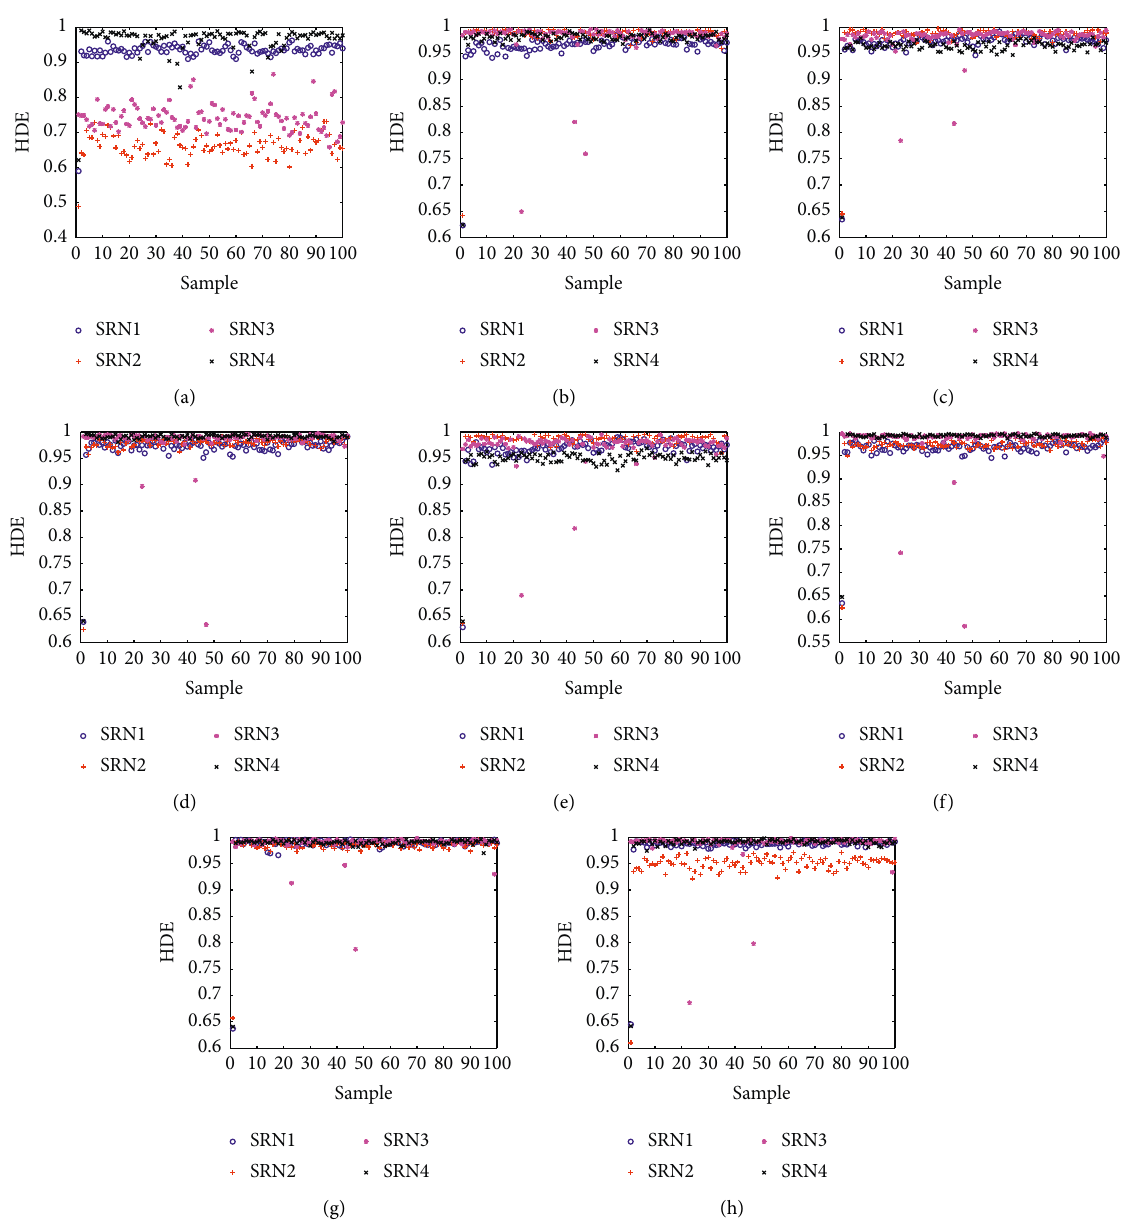
Figure 3: HDE of eight nodes for four types of SRN. (a) Node 1. (b) Node 2. (c) Node 3. (d) Node 4. (e) Node 5. (f) Node 6. (g) Node 7. (h) Node